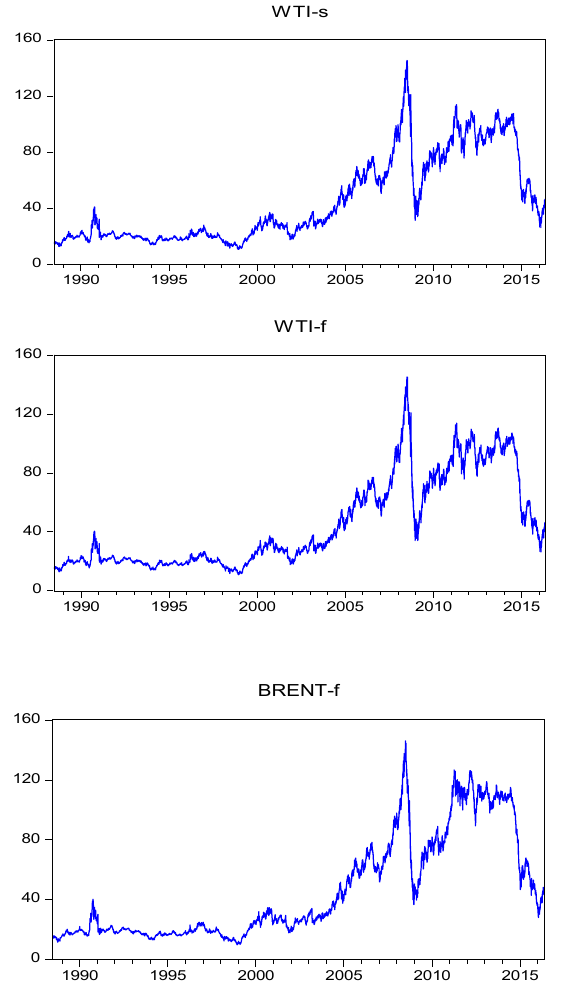
Figure 1. Spot and futures price of WTI and futures price of BRENT, 1988–2016.